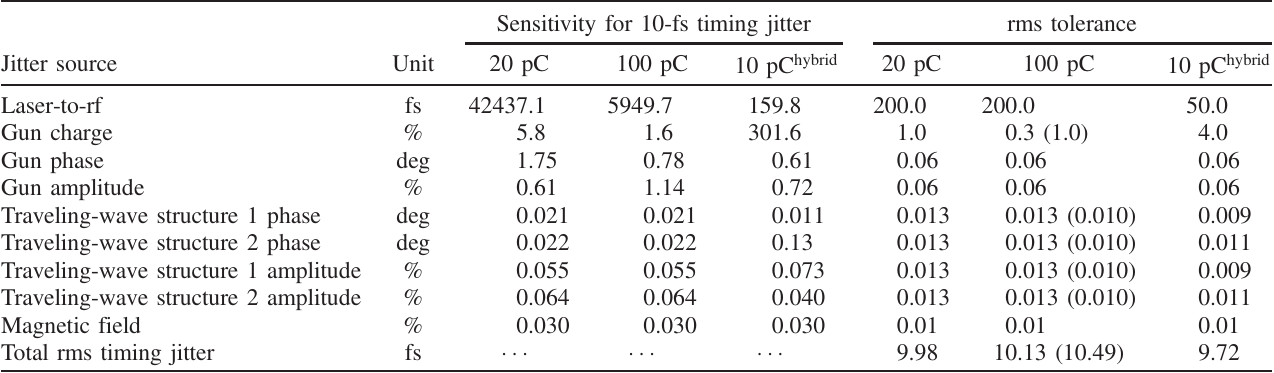
TABLE II. Summary of jitter sensitivity and tolerance